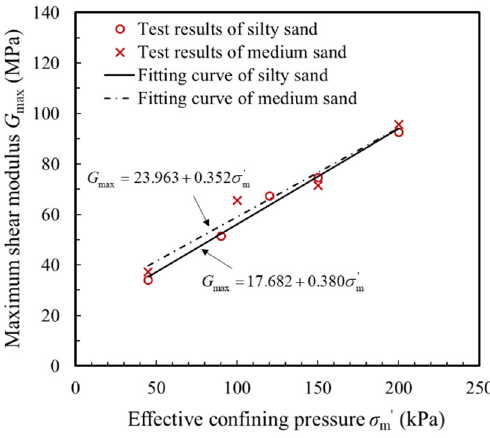
Figure 3. Variation of G max with σ m’ of silty and medium sand.